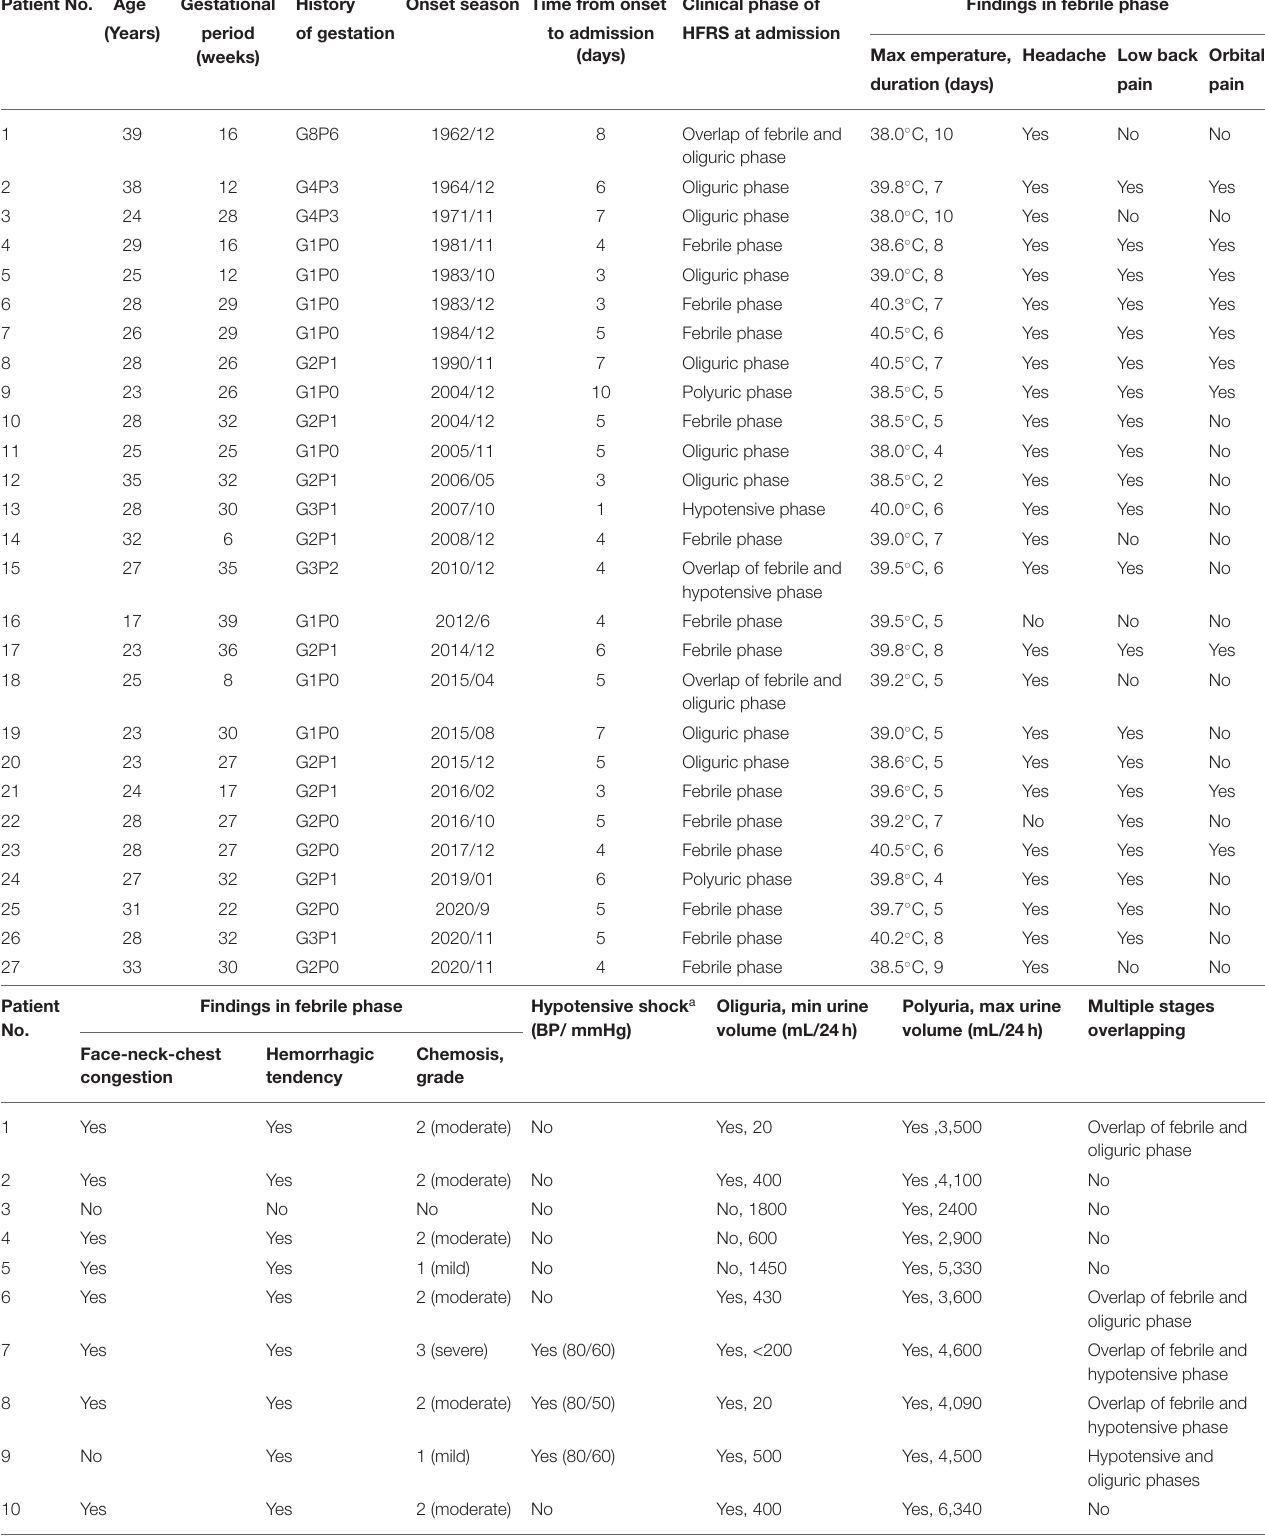
TABLE 1 | General information of the 27 pregnant women with HFRS. Patient No.